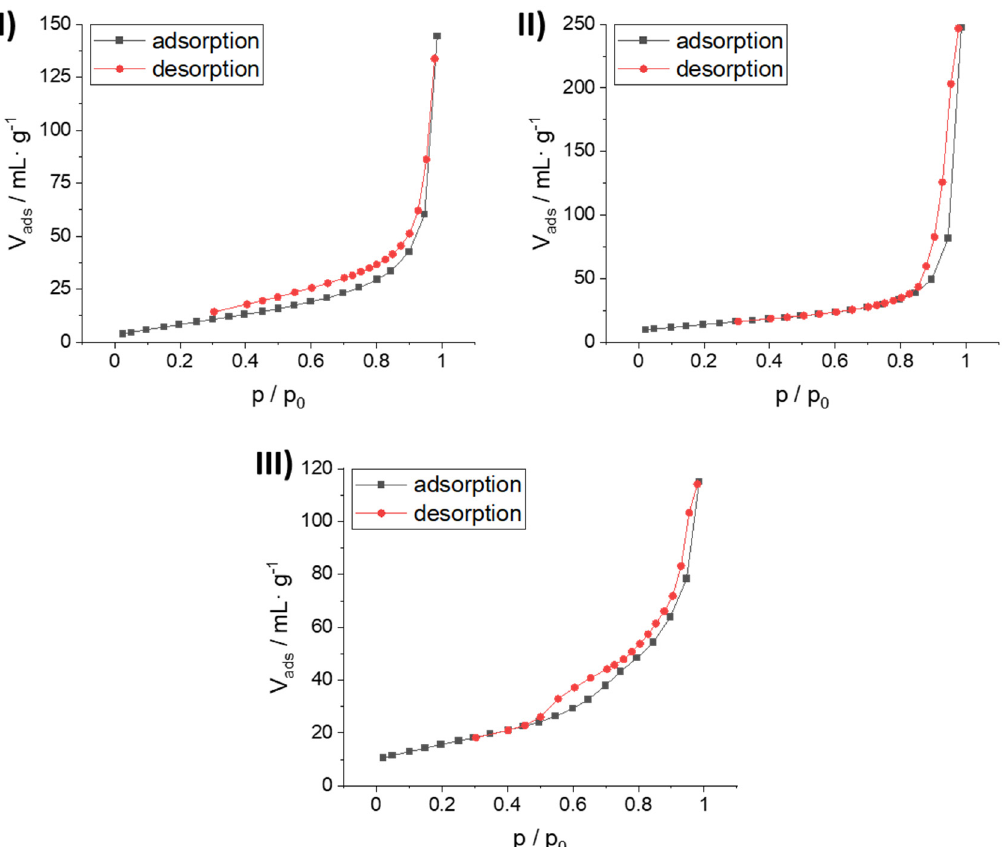
Figure 5. Adsorption (black) and desorption (red) isotherms based upon N 2 gas physisorption measurements according to BET; NOVAtouch 4LX, Quantachrome Instruments; ( I ) P25, as received, ( II ) P25 calcined, ϑ = 500 °C, t = 2 h, pounded and sifted (d < 100 μ m), ( III ) P25 ( II ), combined with Nyacol ® TiSol ‐ NH 4 binder and ethylene glycol, calcined again, ϑ = 500 °C, t = 2 h, pounded and sifted (d < 100 μ m). Isotherm shape indicates the presence of nonporous particle powders for ( I) and ( II) , and shows signs of layer structures for ( III) , according to IUPAC [28].